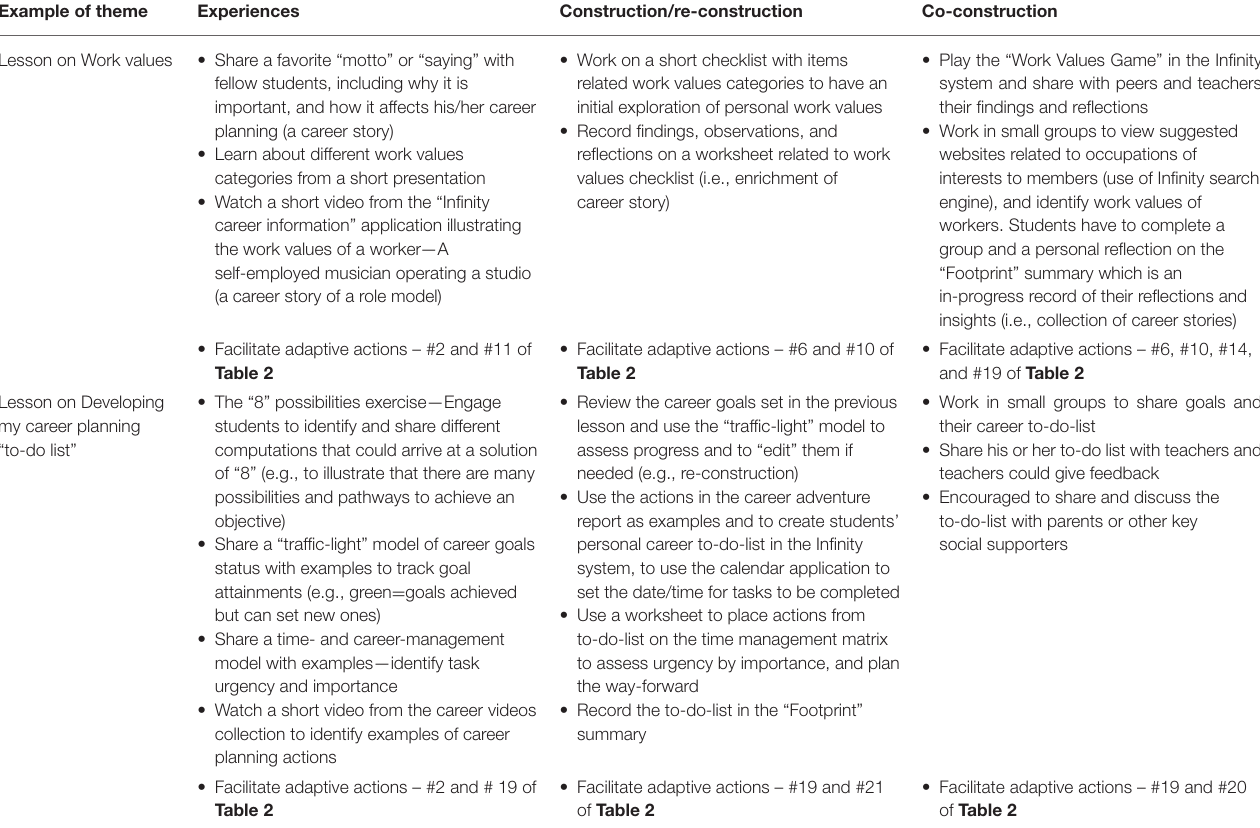
TABLE 3 | Examples of how infinity applications are used in career construction through the career education curriculum. Example of